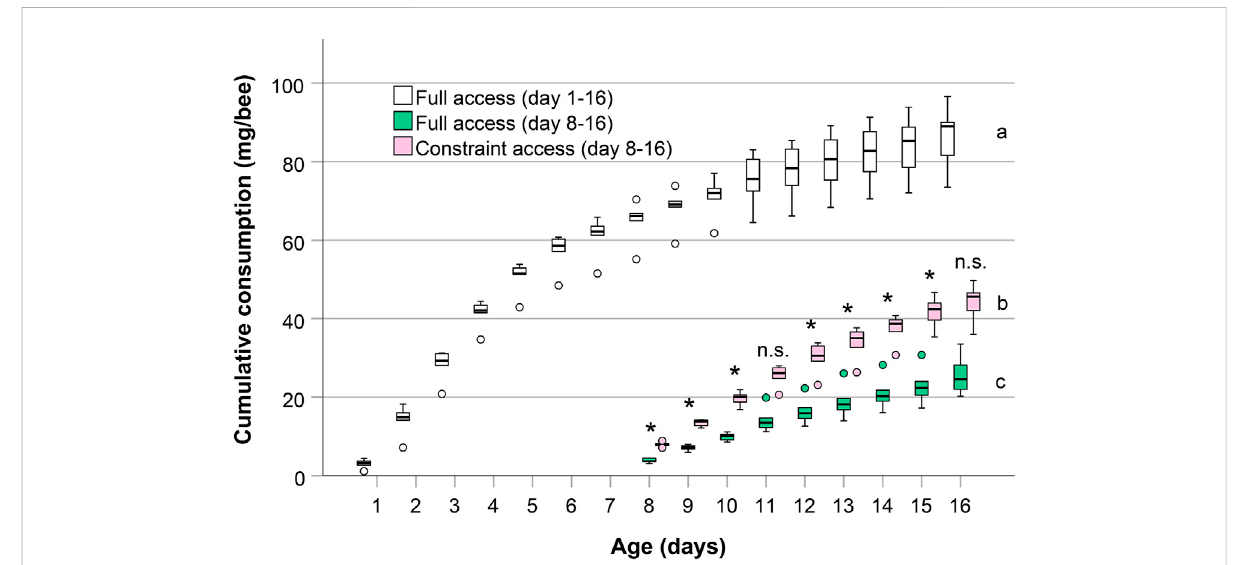
FIGURE 4 Cumulative pollen consumption of bees with unrestricted access and bees constrained of pollen during the fi rst 7 days. For comparison between groups at the later stage, consumption of unrestricted bees on days 8 – 16 is shown seperately. Box and whisker plots (minimum, lower quartile, median, upper quartile, maximum and outliers) for cumulative consumption of pollen (mg/bee) by caged honey bees from day 1 until day 16 and from day 8 until day 16, respectively ( n = 6 cages of bees for each group). Cumulative lifetime consumption at age 16 days was signi fi cantly different (a, b, c: different letters indicate p < 0.001, one-way ANOVA with Bonferroni multiple comparisons post-hoc test). * indicates differences in daily consumption after day 8 between bees with constraint consumption and full consumption ( p < 0.05, Student ’ s t -test). n.s. = not signi fi cant.